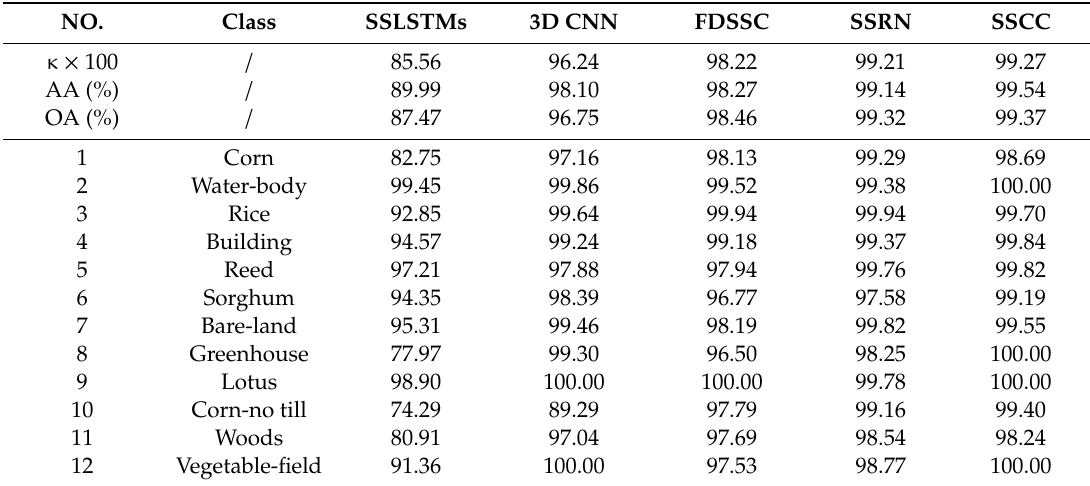
Table 5. Classification results of di ff erent methods for the GF-5 dataset of Anxin